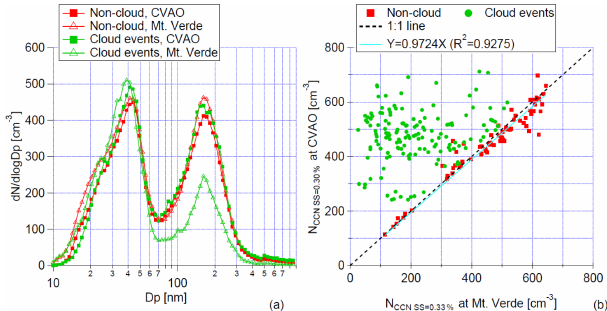
Figure 10. (a) The median of PNSDs for marine-type particles dur- ing cloud events and non-cloud events at CVAO and MV; (b) scatter plots of N CCN at CVAO against those at MV at a supersaturation of ∼ 0 . 30%. Slope and R 2 are given. This figure was adapted from Fig. 9 in Gong et al. (2020a).